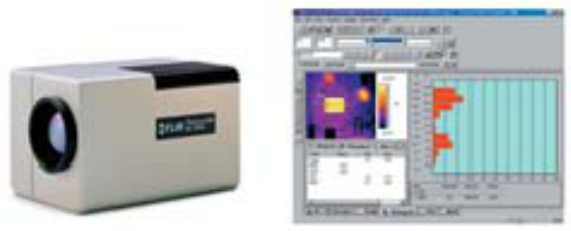
Figure 12. FLIR Thermacam SC3000 High Speed Thermal Imaging System